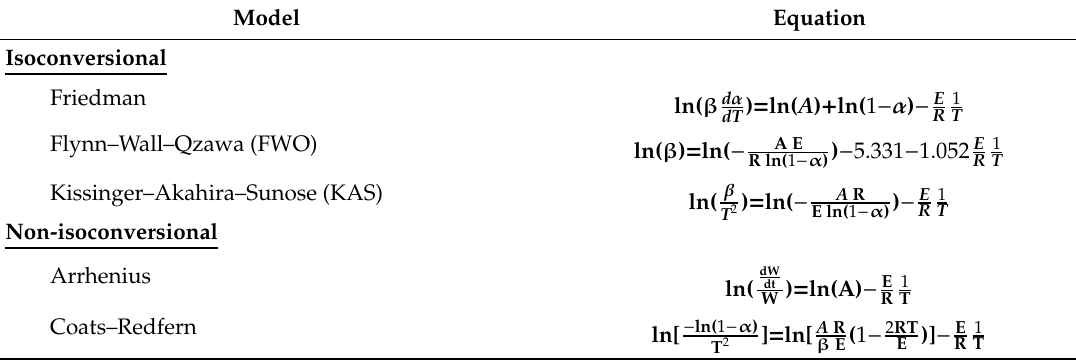
Table 4. Equations of the selected models